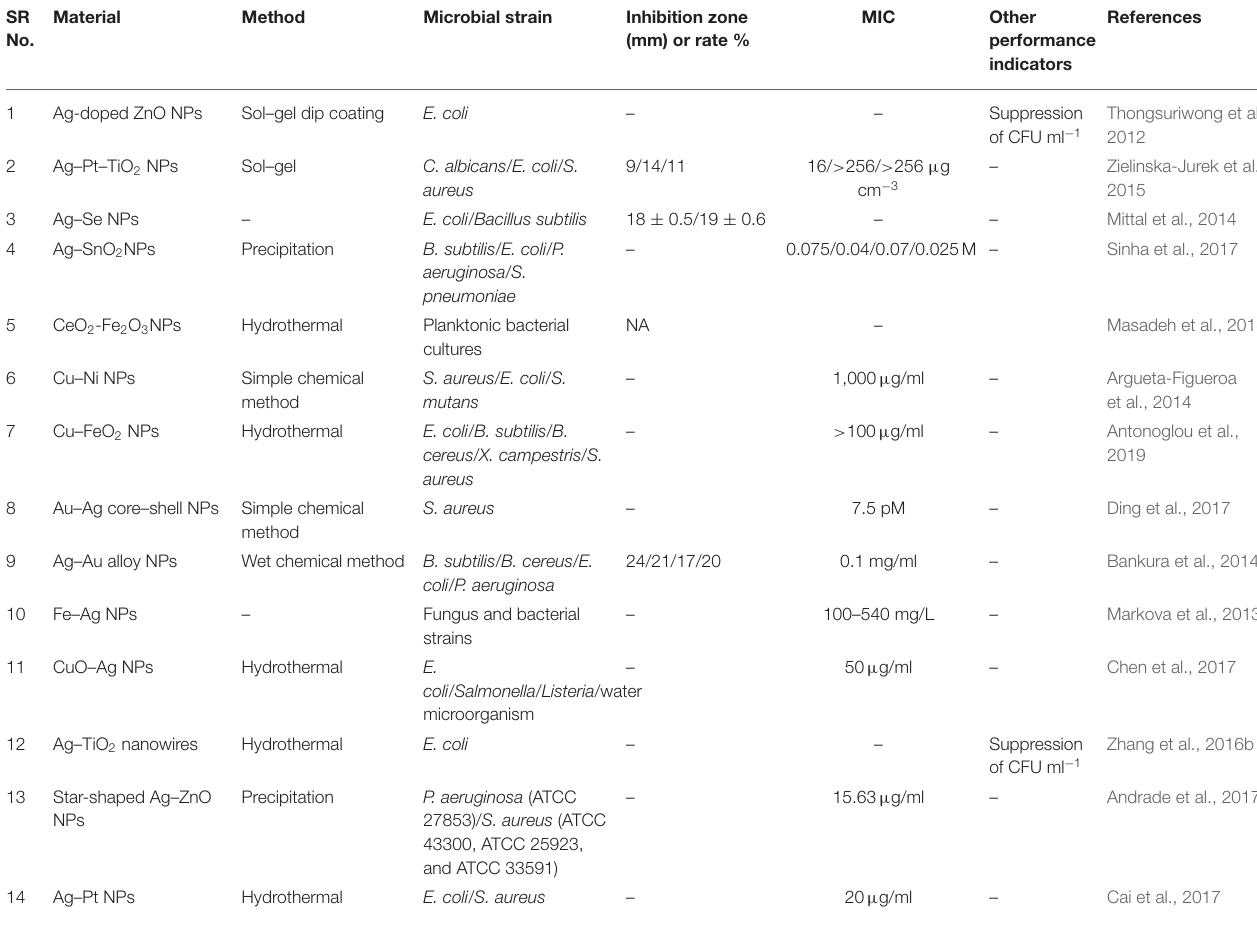
TABLE 6 | Types and antimicrobial properties of non-supported bimetallic nanoparticles. SR No.